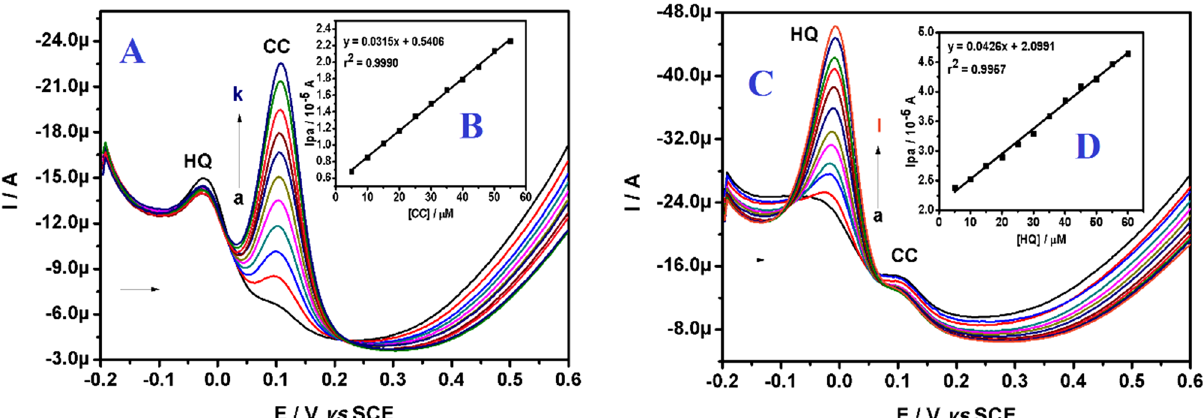
Figure 12. ( A ) DPVs of varying concentration of CC in presence of 20.0 μM HQ at polysorbate/CPE in buffer (0.2 M PBS; pH 7.4). ( B ) Linear plot of Ipa versus concentration of CC. ( C ) DPVs of varying concentration of HQ in presence of 20.0 μM CC at polysorbate/CPE in buffer (0.2 M PBS; pH 7.4). ( D ) Linear plot of Ipa versus concentration of HQ. Current change Interferents